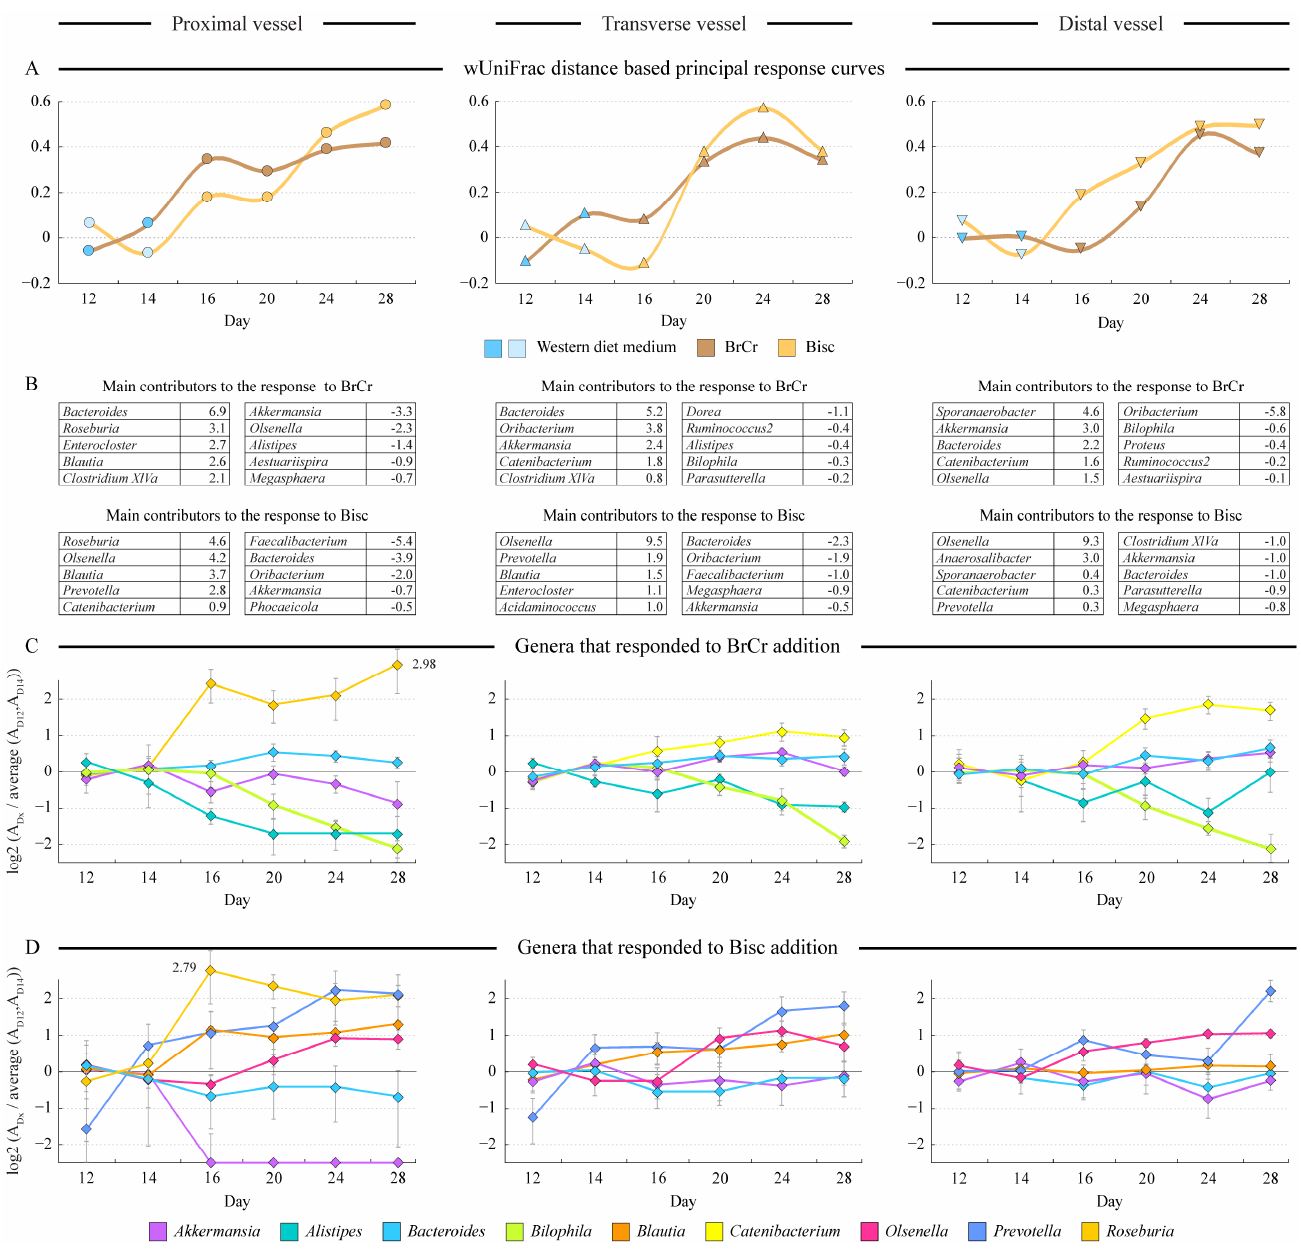
Figure 3. Longitudinal analysis of microbiota community changes upon melanoidin supplementation. Panel ( A ) displays the results of weighted UniFrac distance based principal response curves (dbPRC) analysis. Consensus community composition on days 12 and 14 (representing stabilized community on Western diet medium) were set as baseline for that run type (Bisc or BrCr) and were compared to the microbiota composition at every other time point. Larger deviation from zero on the Y axis represents greater shift of community structure from that of the baseline. The main microbial drivers of the observed shifts in the community composition are shown in the tables in panel ( B ). Positive numbers represent genera that increased in their abundance after medium switch; negative numbers represent genera that decreased. The change in abundance of several of these genera at different time points are shown in panels ( C , D ), defined as the log2 of the ratio of genus abundance in particular sample divided by the average of abundances on days 12 and 14. Value of one thus represents a two-fold increase in abundance. Error bars represent standard deviation of ratios calculated separately for each replicate run.